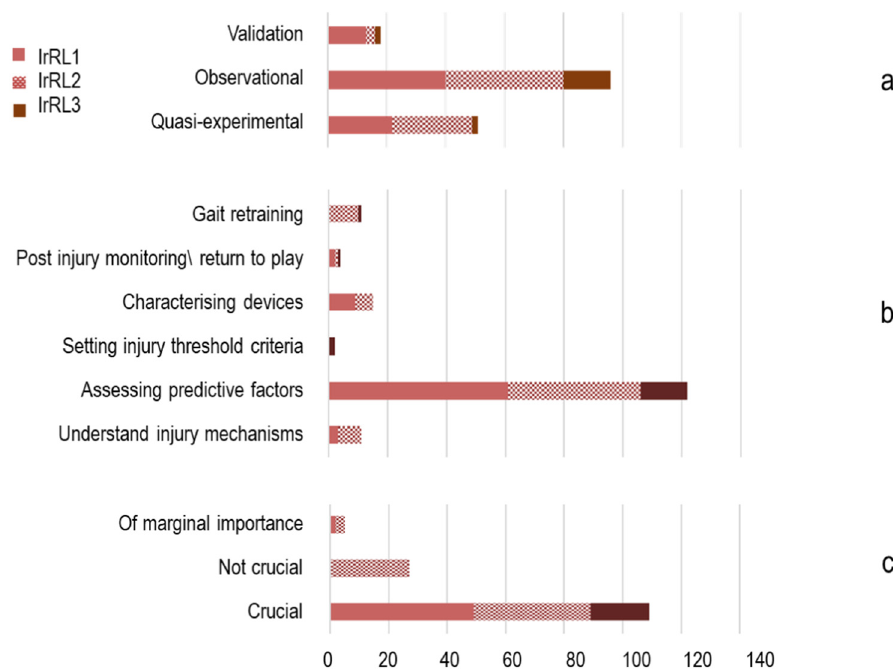
Figure 9. Distribution of studies at different IrRL levels is reported from different perspectives: ( a ) strength of evidence; ( b ) scope; ( c ) relevance of wearable-based parameters.